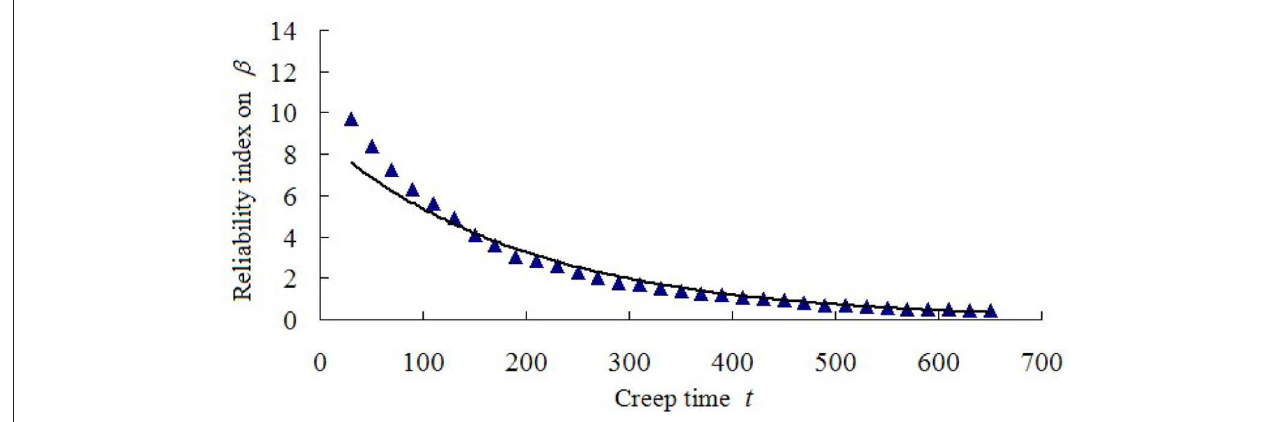
FIGURE 5 | Curve of reliability index and creep time (Unit: